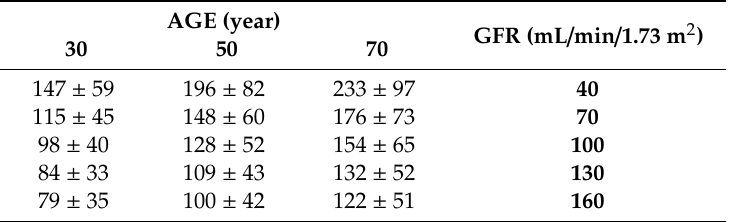
Table 3. Simulated mean ± standard deviation of levofloxacin area under the curve (AUC) (in mg h / L) for a 750 mg per day dose, according to age and glomerular filtration rate.